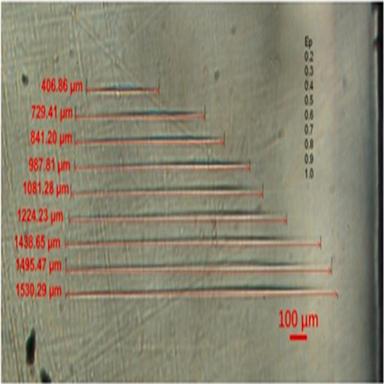
Profile view of filamentary structures written by pulse energy 0.2 μJ–1.0 μJ.